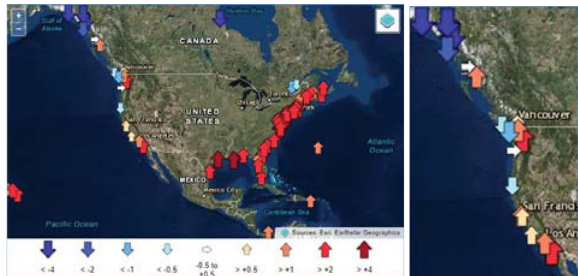
Figure 2: Locations of the tide gauges with more than 80 years of data in the PSMSL database. Image reproduced modified after [3]